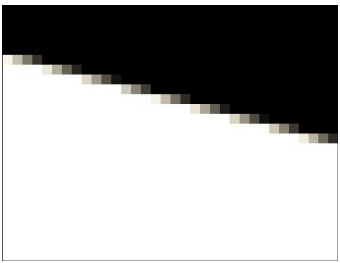
Figure 5. When we reproject an orthoimage to a different UTM zone, empty wedges appear again (right). The borders of these wedges have “intermediate” values due to Figure 3. The alignment of the pixels at the original GSD (green pixels of LOD=n are aligned) does not ensure pixel alignment in the next levels of the pyramid, LOD=n-1 and LOD= n-2 (blue and red pixels are nonaligned) Problem 3: Images in different Zones of the map projections